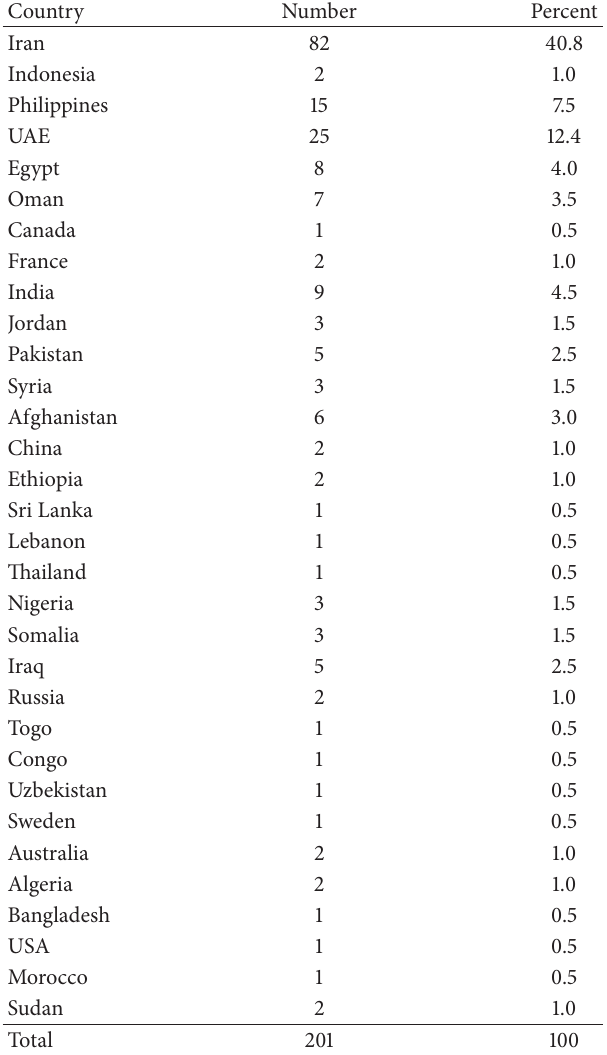
Table 1: Different nationalities of studied population enrolled for detection of Herpes simplex virus, Chlamydia trachomatis , and Neisseria gonorrhoeae infection among married Women, Dubai,